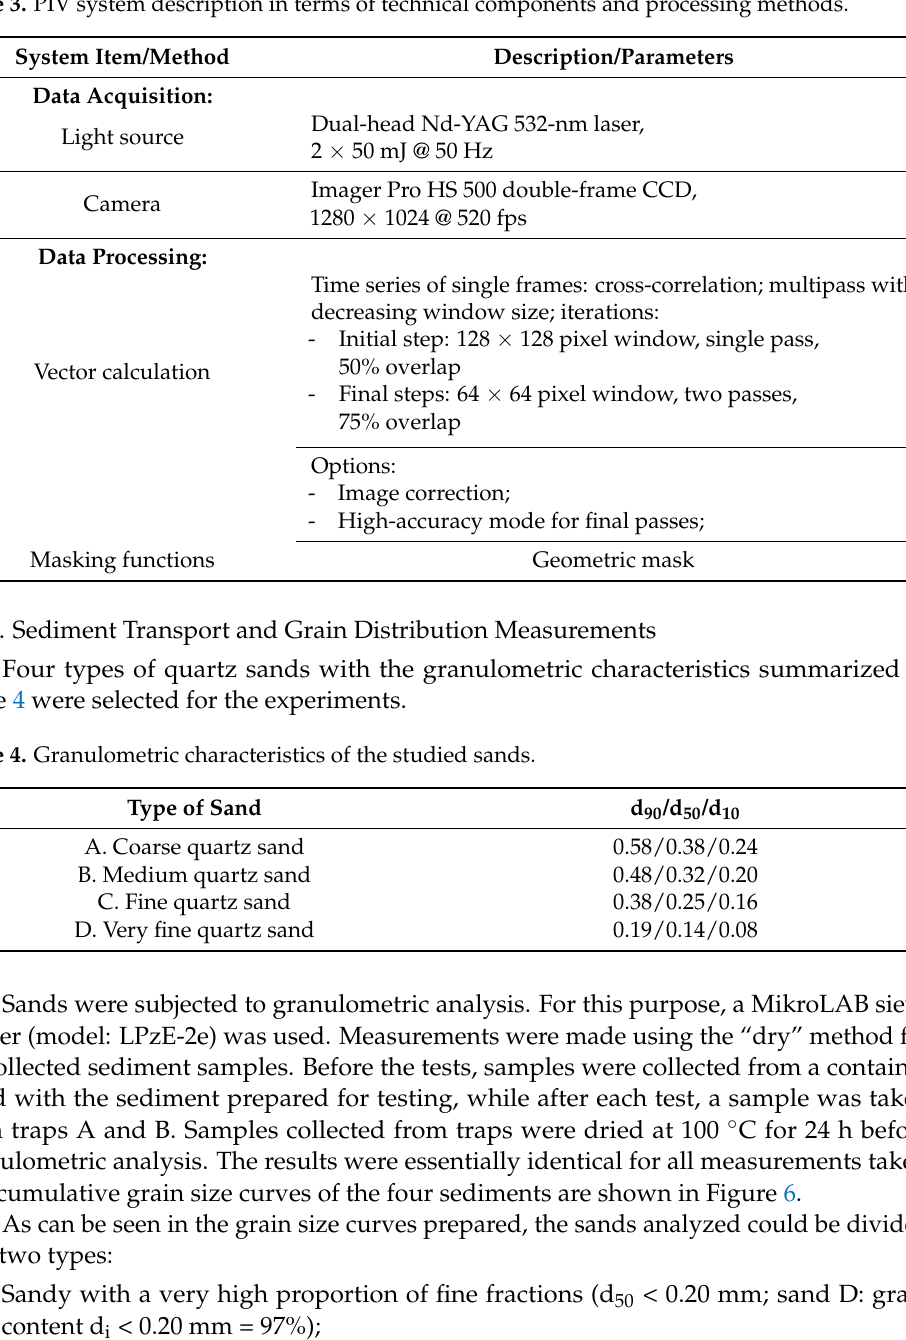
Table 3. PIV system description in terms of technical components and processing methods.